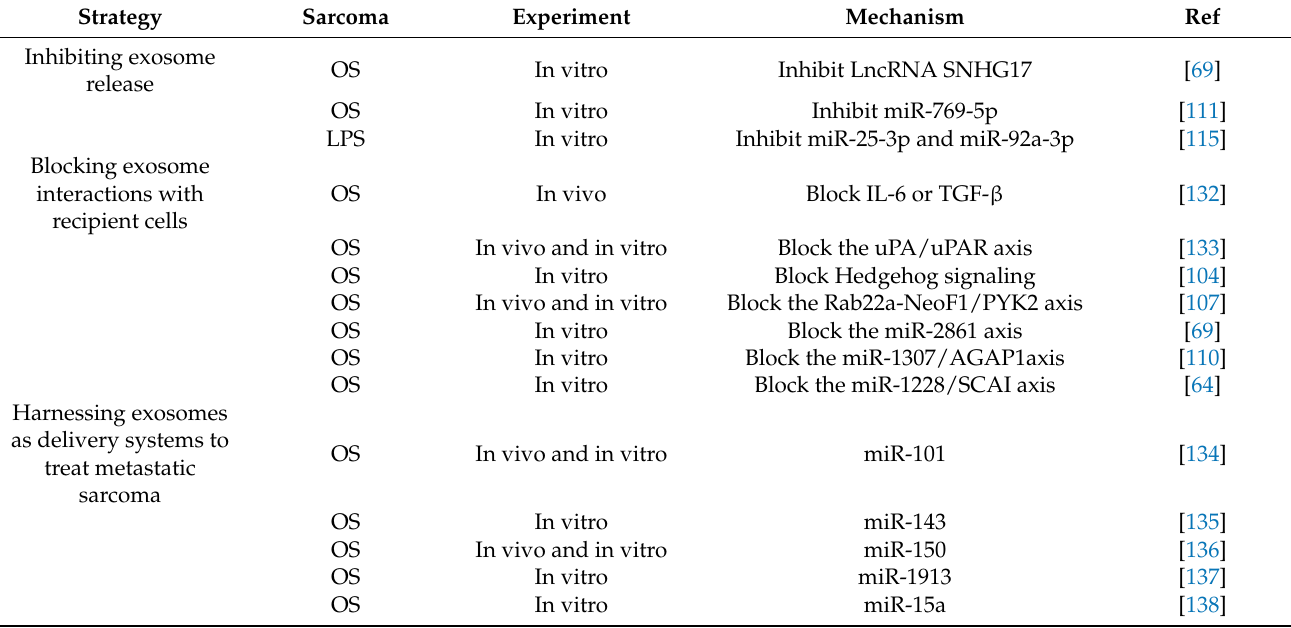
Table 2. Exosome-associated therapeutic strategies for sarcoma